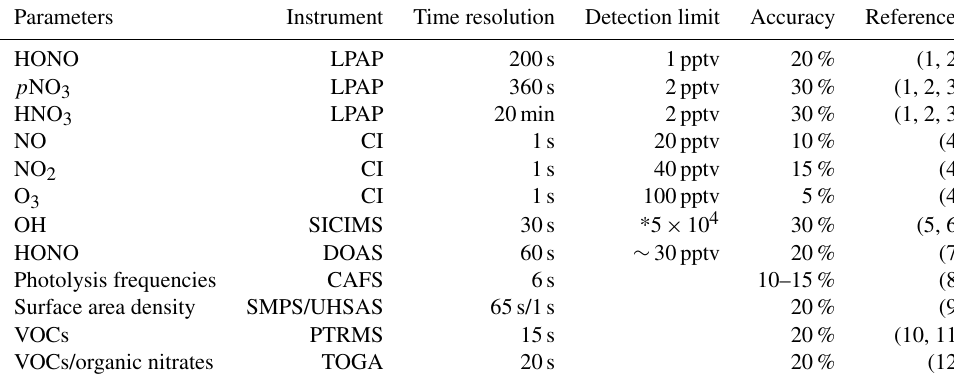
Table 1. Measurements from the NOMADSS 2013 summer study used in this analysis. Parameters Instrument Time resolution Detection limit Accuracy HONO LPAP LPAP